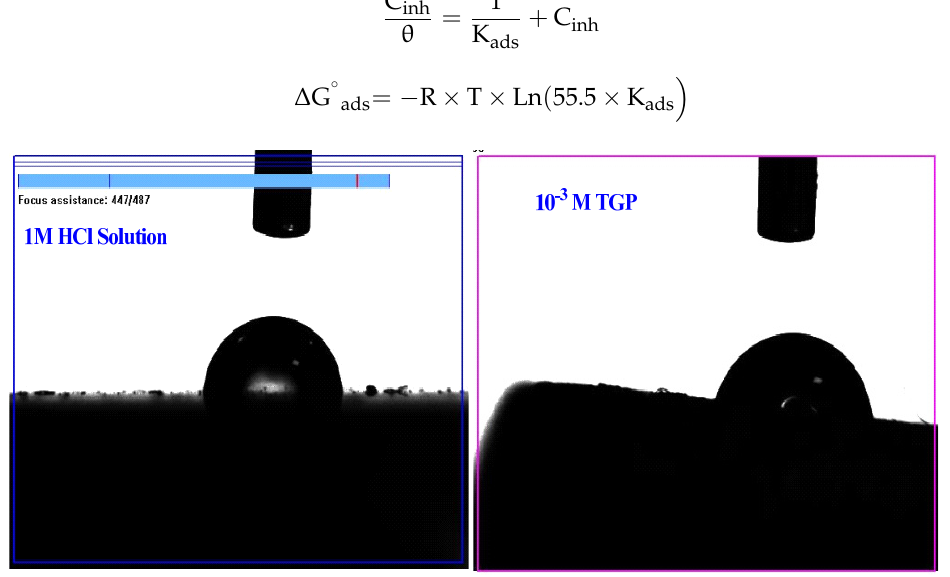
Figure 7. CA analysis of MS after immersion in 1 M HCl solution, both unprotected and protected by 10 − 3 M of TGP.